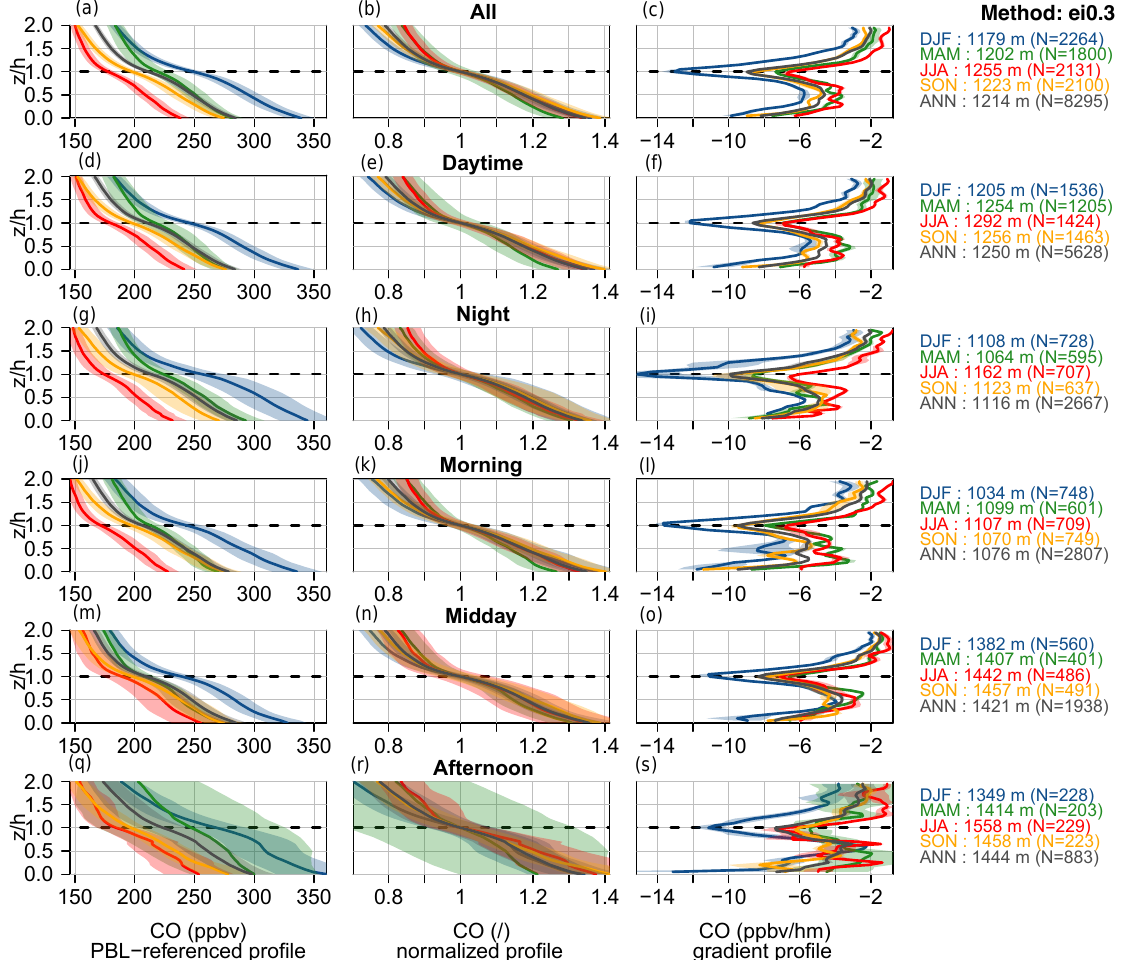
Figure 11. Same as Fig. 7 for CO mixing ratios (in